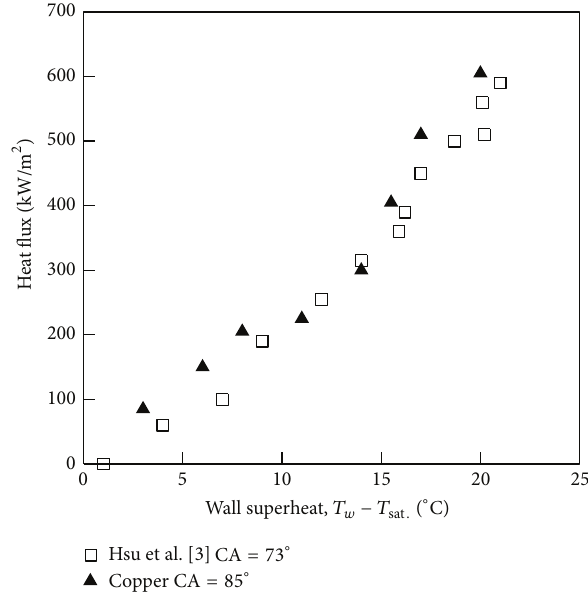
Figure6:Comparisonofcoppersurfaceboilingheatfluxcurvewith Hsu et al.